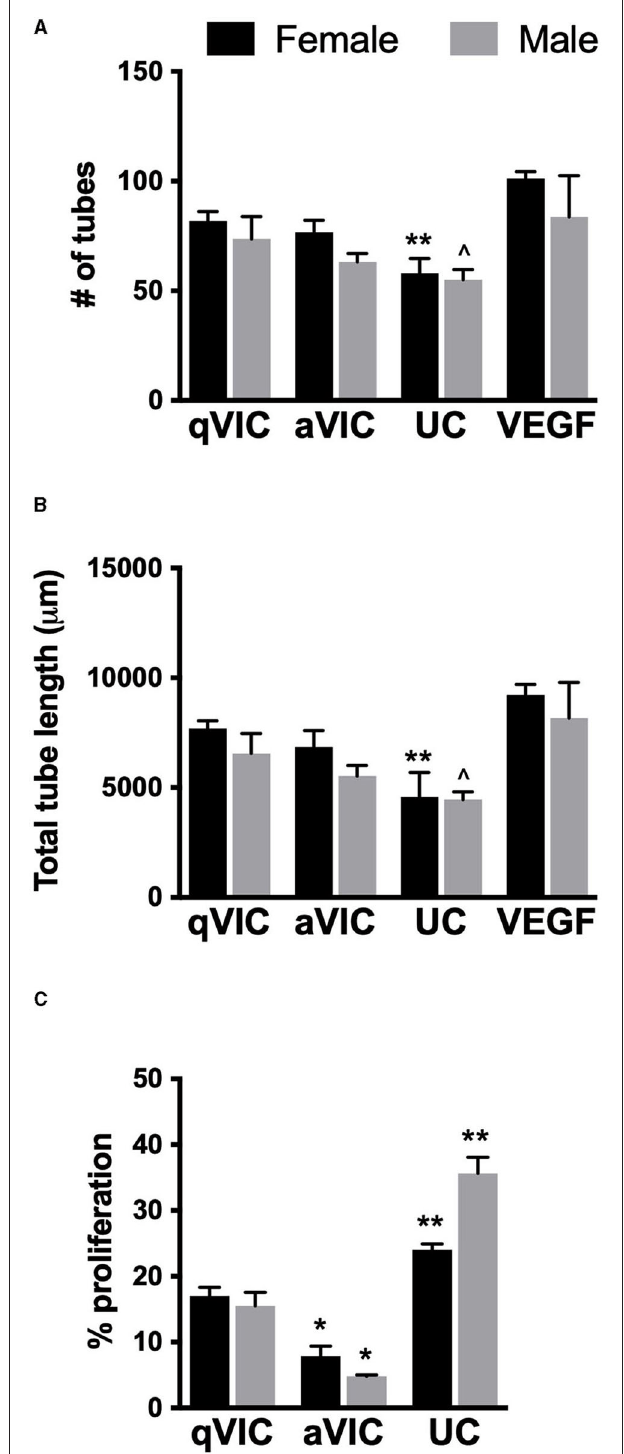
FIGURE 4 | Effect of VIC-conditioned media on VEC function. (A) Number, (B) length of tubules formed by VECs in tubulogenesis assay, and (C) VEC proliferation. * p < 0.05 vs. sex-matched qVIC condition; ** p < 0.05 vs. sex-matched aVIC and qVIC conditions by two-way ANOVA with Tukey’s post hoc test. UC = unconditioned media. N = 3–4 pigs per sex, n = 3 wells per